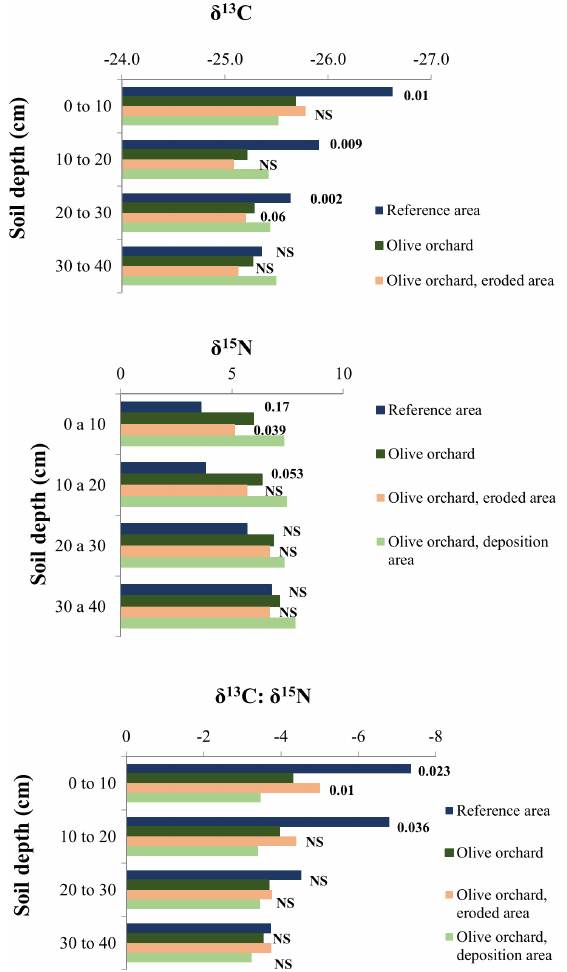
Figure 8. 13 C and 15 N isotopic signal of soil by depth distinguish- ing among reference site, the whole olive orchard, the eroded area of the olive orchard, and the deposition area in this orchard. The labels of the bars for each depth indicate the p value according to a one-way ANOVA between the reference area (dark blue) vs. the whole olive orchard (dark green) and the eroding area (beige) vs. the deposition area (light green, lower label, in italics).